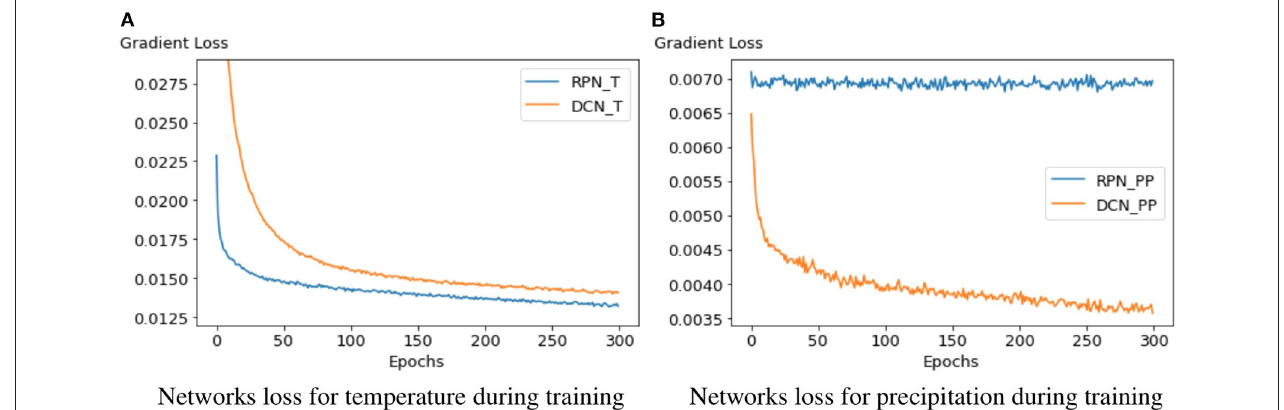
FIGURE 3 | Validation loss plots of both architectures on temperature and precipitation. The left plot shows that RPN converges faster and achieves a lower loss during training for the temperature field than DCN. On the other hand, we see that the same RPN architecture is unable to learn when applied on precipitation data. (A) Network loss for temperature during training. (B) Network loss for precipitation during training.